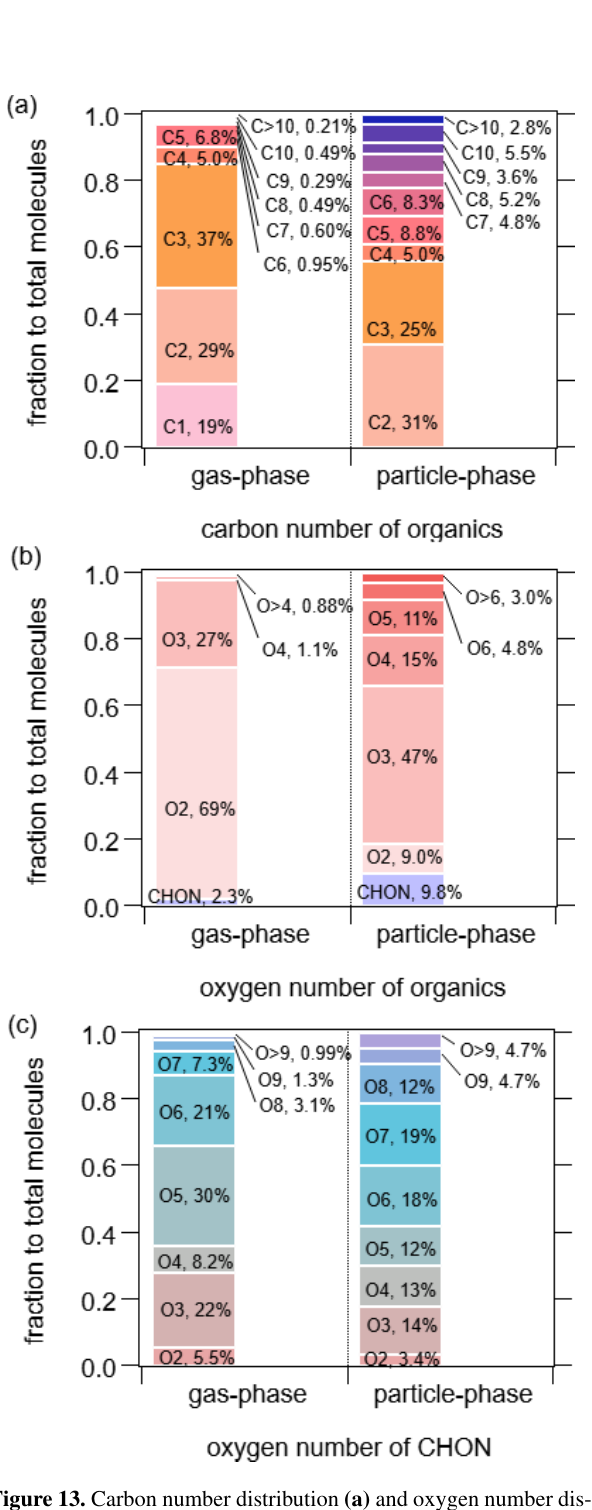
Figure 13. Carbon number distribution (a) and oxygen number dis- tribution of total C x H y O z and C x H y N 1 , 2 O z compounds (b) and oxygen number distribution of C x H y N 1 , 2 O z compounds (c) .